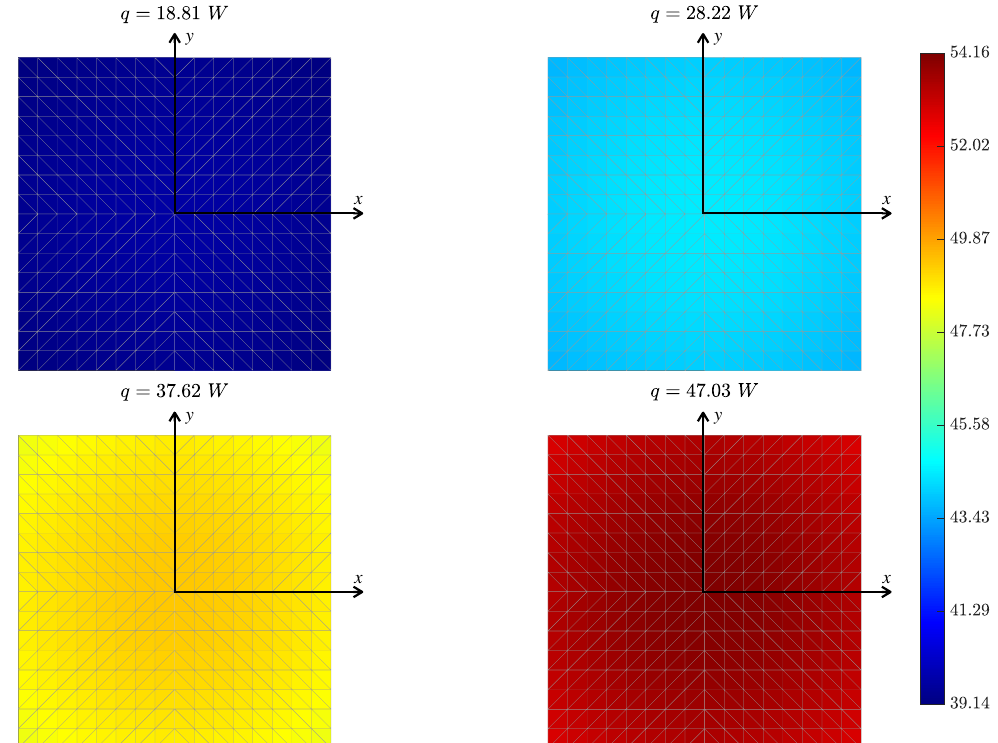
Figure A9. Maximum temperature at the base of the microprocessor for: q = 18.81W, q = 28.22W, q = 37.62W and q =